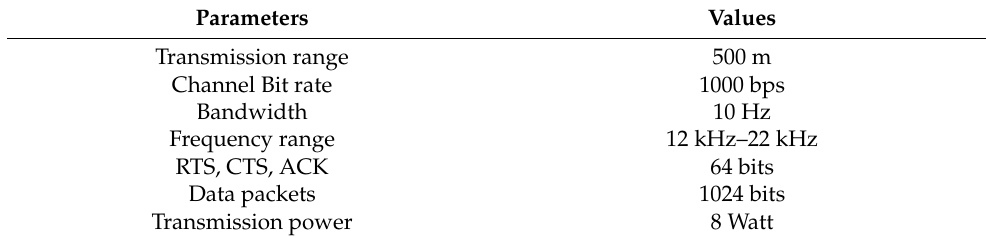
Table 3. Simulation parameters used by the HS-FD-MAC protocol.